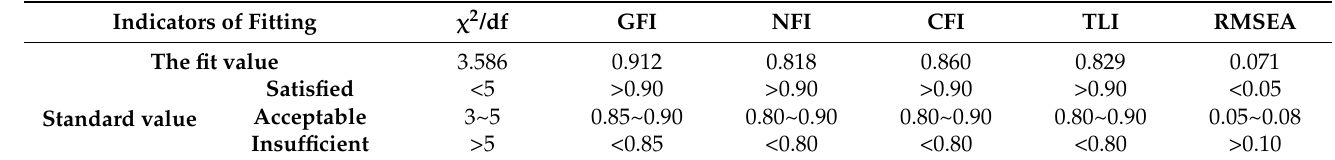
Table 8. The fitted results for